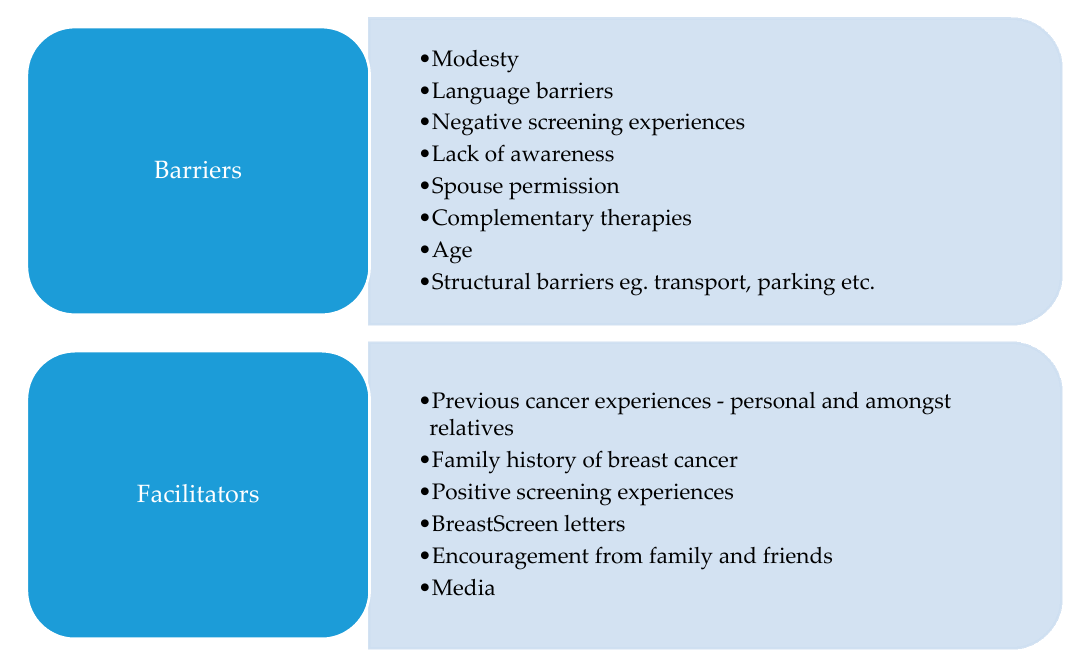
Figure 1. Summary of barriers and facilitators.